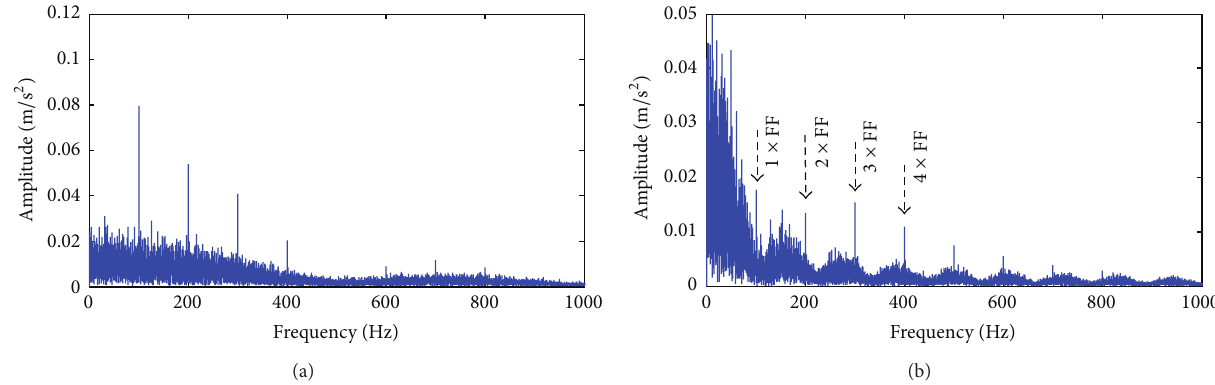
Figure 16: (a) Frequency spectrum of filtered signal by second length of SE; (b) frequency spectrum of filtered signal by ninth length of SE.